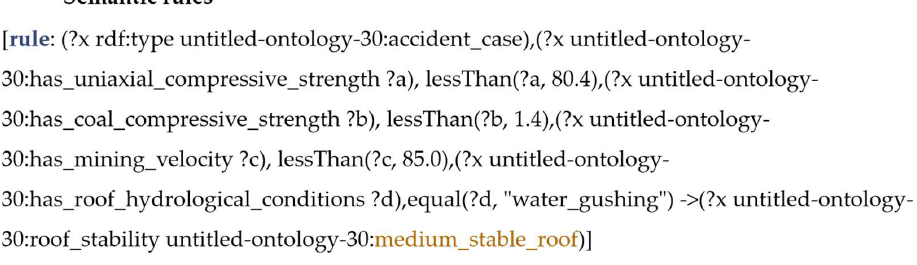
Figure 9. Example of semantic rules for coal mine roof stability through data